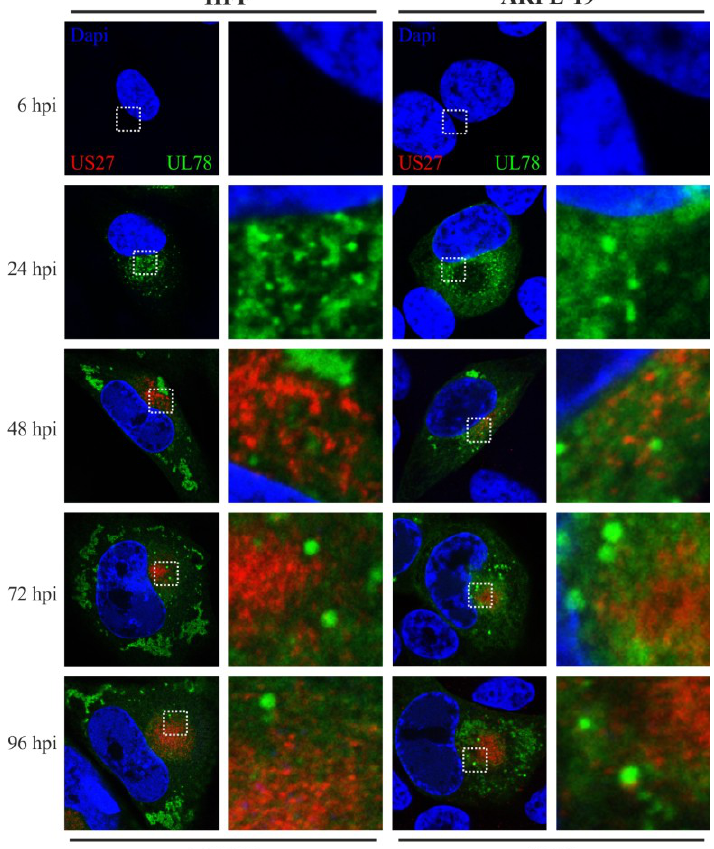
Figure 7. Colocalization analysis of Flag-US27 and UL78-EYFP in infected HFFs and ARPE-19 cells. HFF (left panel) or ARPE-19 cells (right panel) were infected with a recombinant TB40/E virus (MOI: 0.5 or 1) expressing fusion proteins of both pUS27 (red) and pUL78 (green) with Flag or EYFP, respectively, and fixed at different time points during HCMV infection (24–96 hpi). Cells were stained with primary antibody mAb-Flag, diluted 1:400, in combination with the secondary anti-mouse antibody coupled to Alexa-555 (1:400) in order to detect pUS27. Cell nuclei were stained with